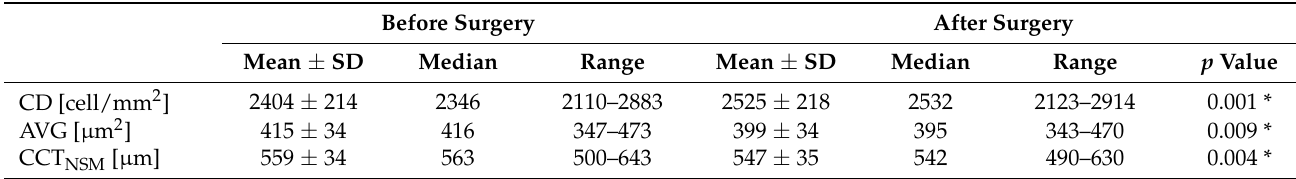
Table 2. Corneal endothelium measurements from non-contact specular microscopy.